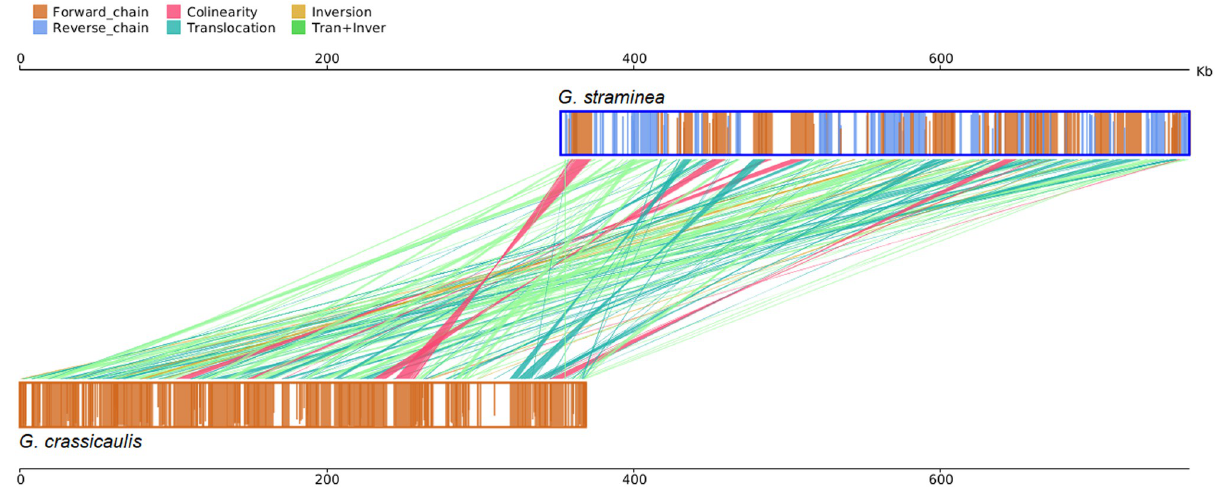
Fig 5. Collinear relationship between the mitochondrial genomes of Gentiana crassicaulis and G . straminea . The upper and lower bars represented the mitochondrial genomes. Dark-orange and blue regions in each bar represented the forward and reverse direction of the aligned genome, respectively. White regions in each bar represent the sequences that could not be aligned to the other genome. Lines between the two bars indicated the syntenic types and locations: magenta, blue-green, dark yellow and light-green represent collinearity, translocation, inversion and translocation +inversion,